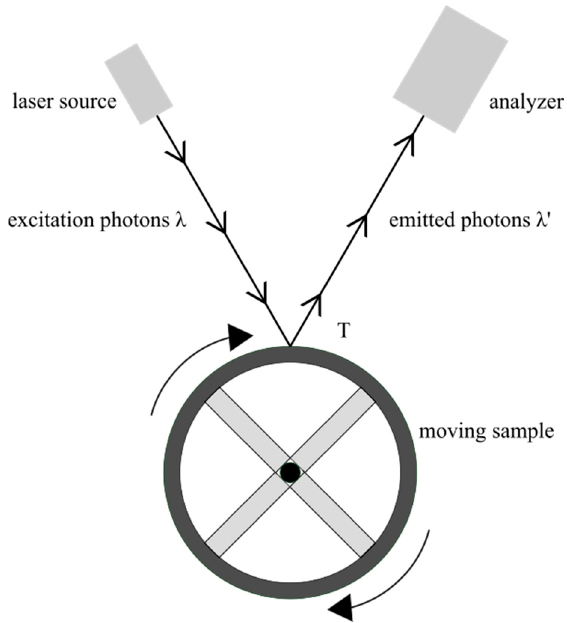
Figure 11. Non-contact thermometry based upon temperature-dependent, laser-induced lumines- cence of a rapidly rotating sample. Only excitation photons impinge on the sample. No physical or mechanical contact with the sample is required [19].